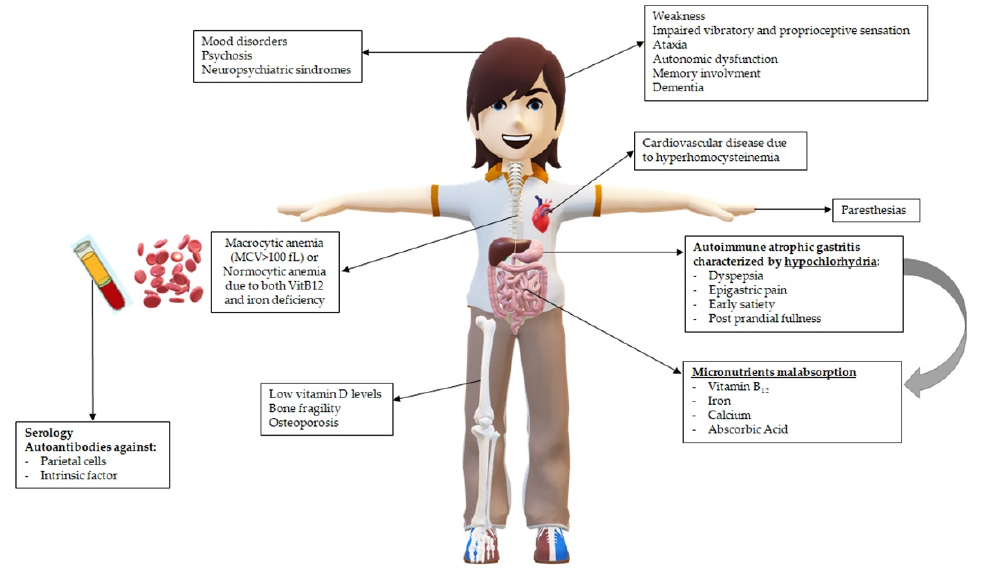
Figure 1. Main clinical consequences in patients with pernicious anemia (PA) related to hypochlorhydria and vitamin B 12 deficiency.